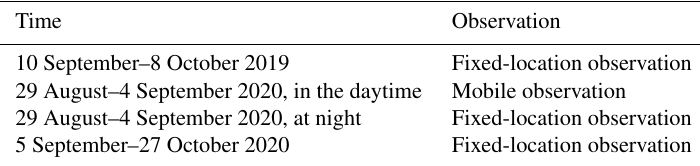
Figure 1. Location of the Haizhu Lake Research Base and the mobile observation area. Table 1. Observations with the vehicle-based multi-lidar